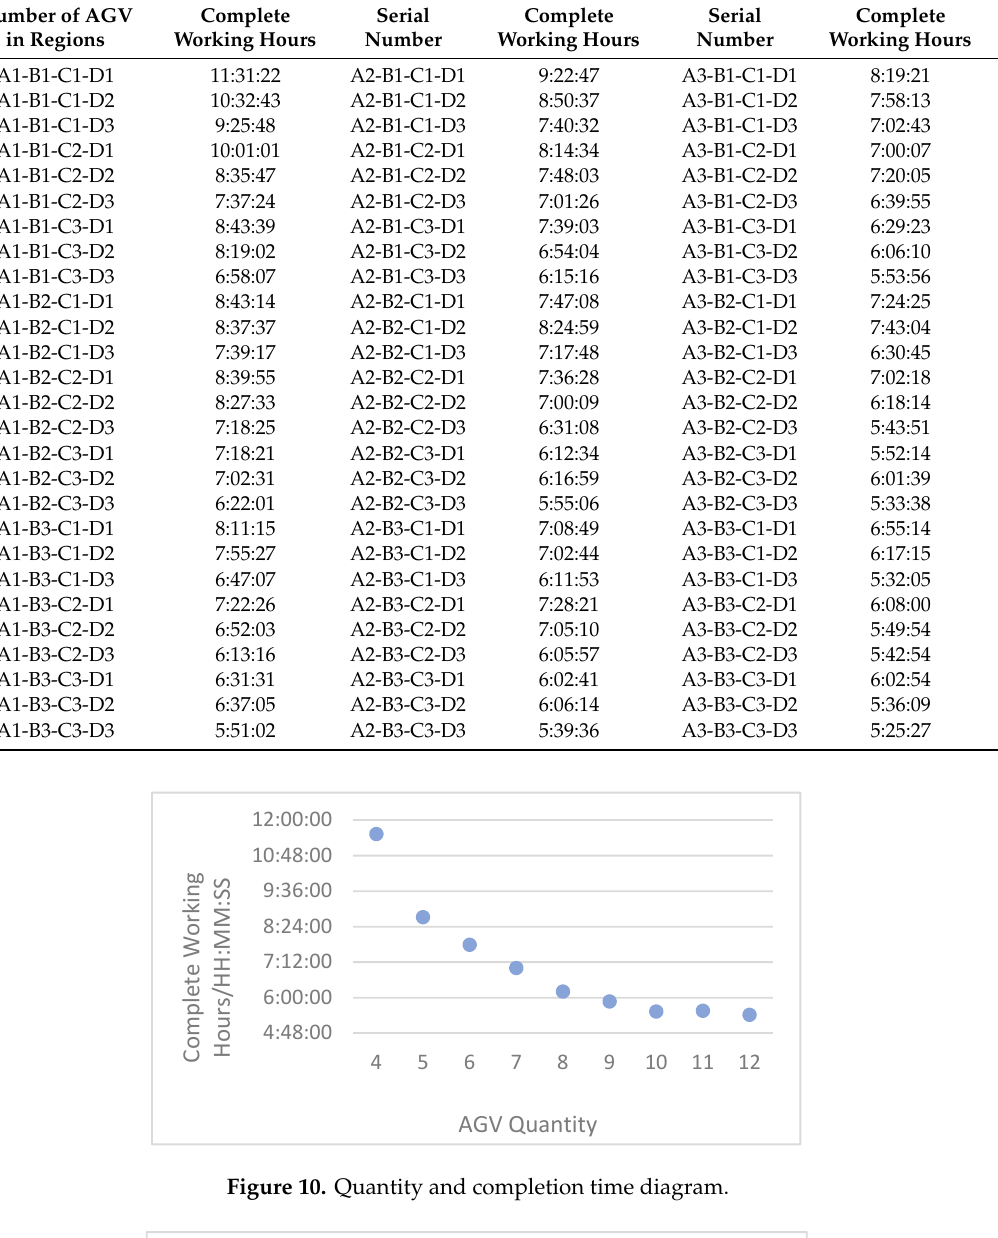
Figure 10. Quantity and completion time diagram. Electronics 2020 , 9 , x FOR PEER REVIEW